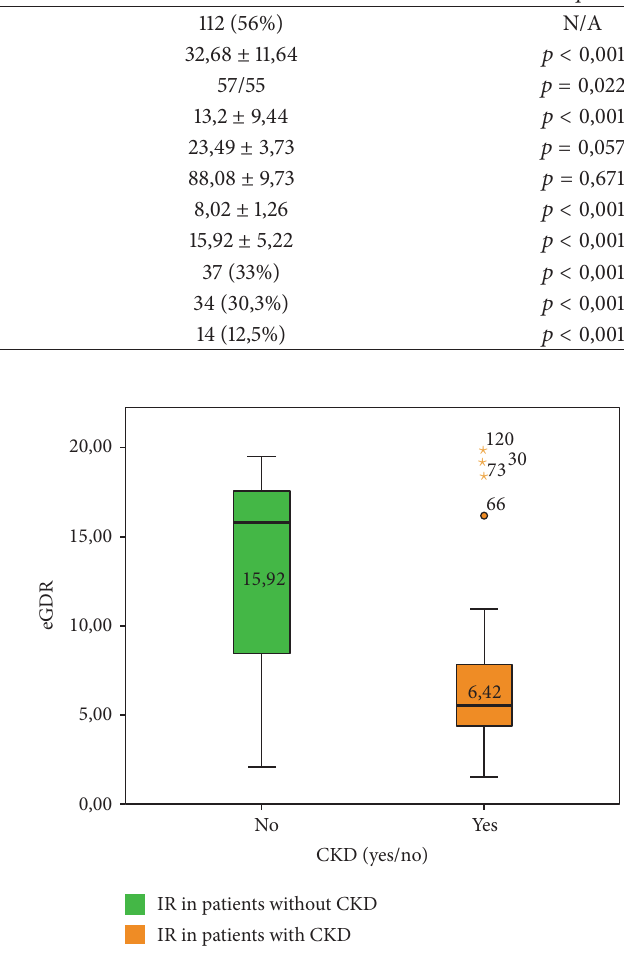
Figure 3: Insulin resistance in CKD patients.